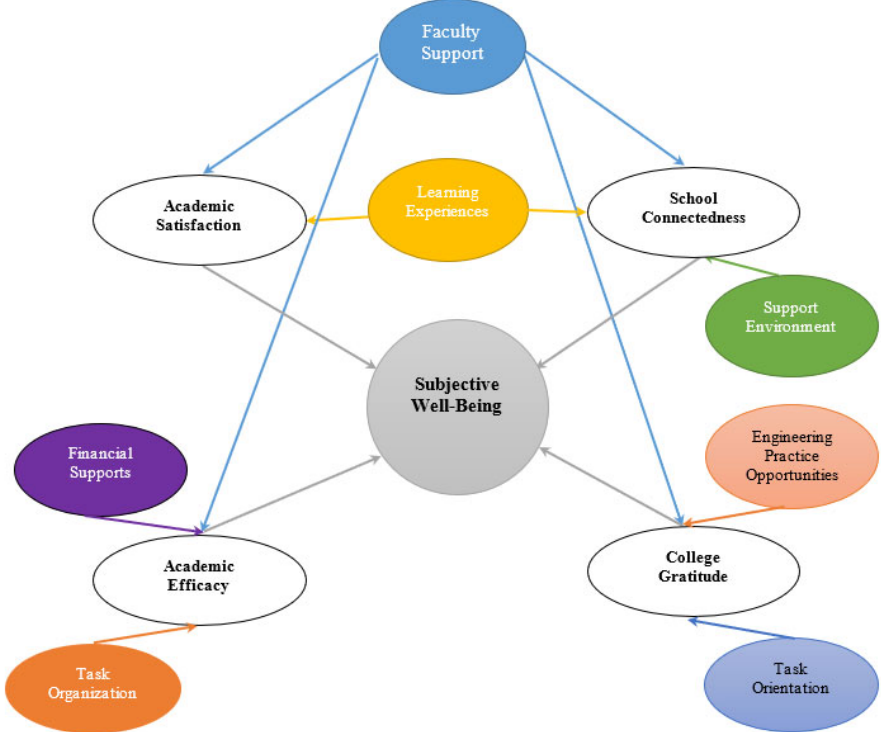
Figure 1. Seven factors model: seven factors perceived to contribute to cumulative SWB via four constructs.